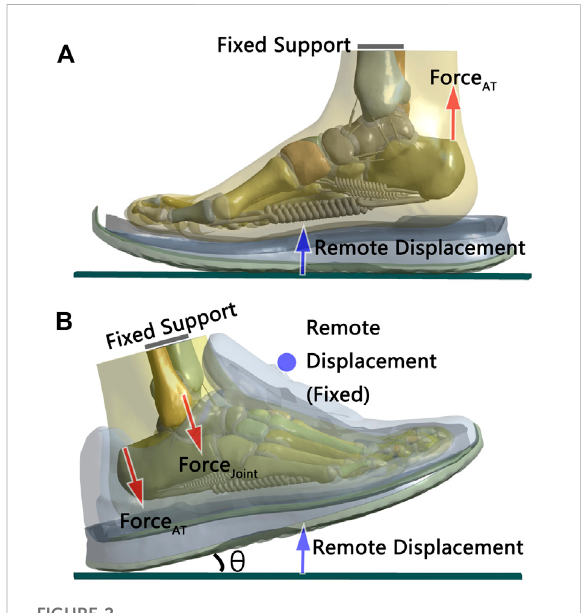
FIGURE 2 FE model and boundary set-up for (A) static standing and (B) rearfoot striking. “ θ ” represented the foot strike angle between the shoe model and ground